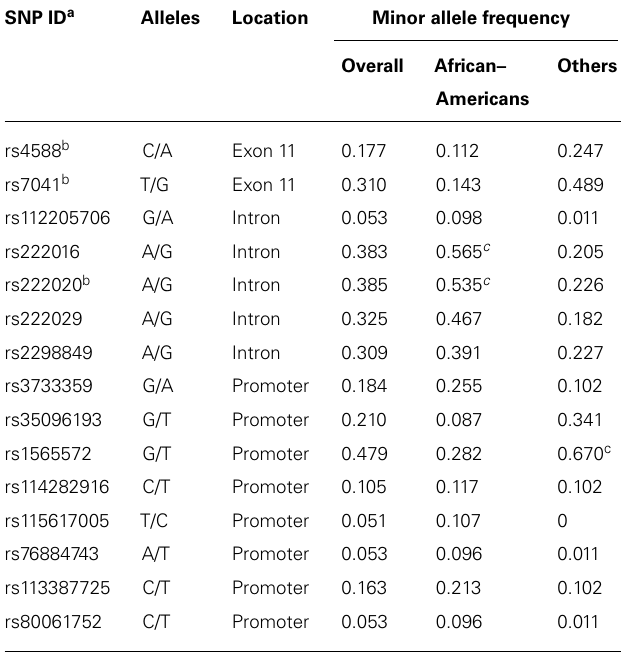
Table 2 | Minor allele frequency for 15 GC SNPs resolved by DNA